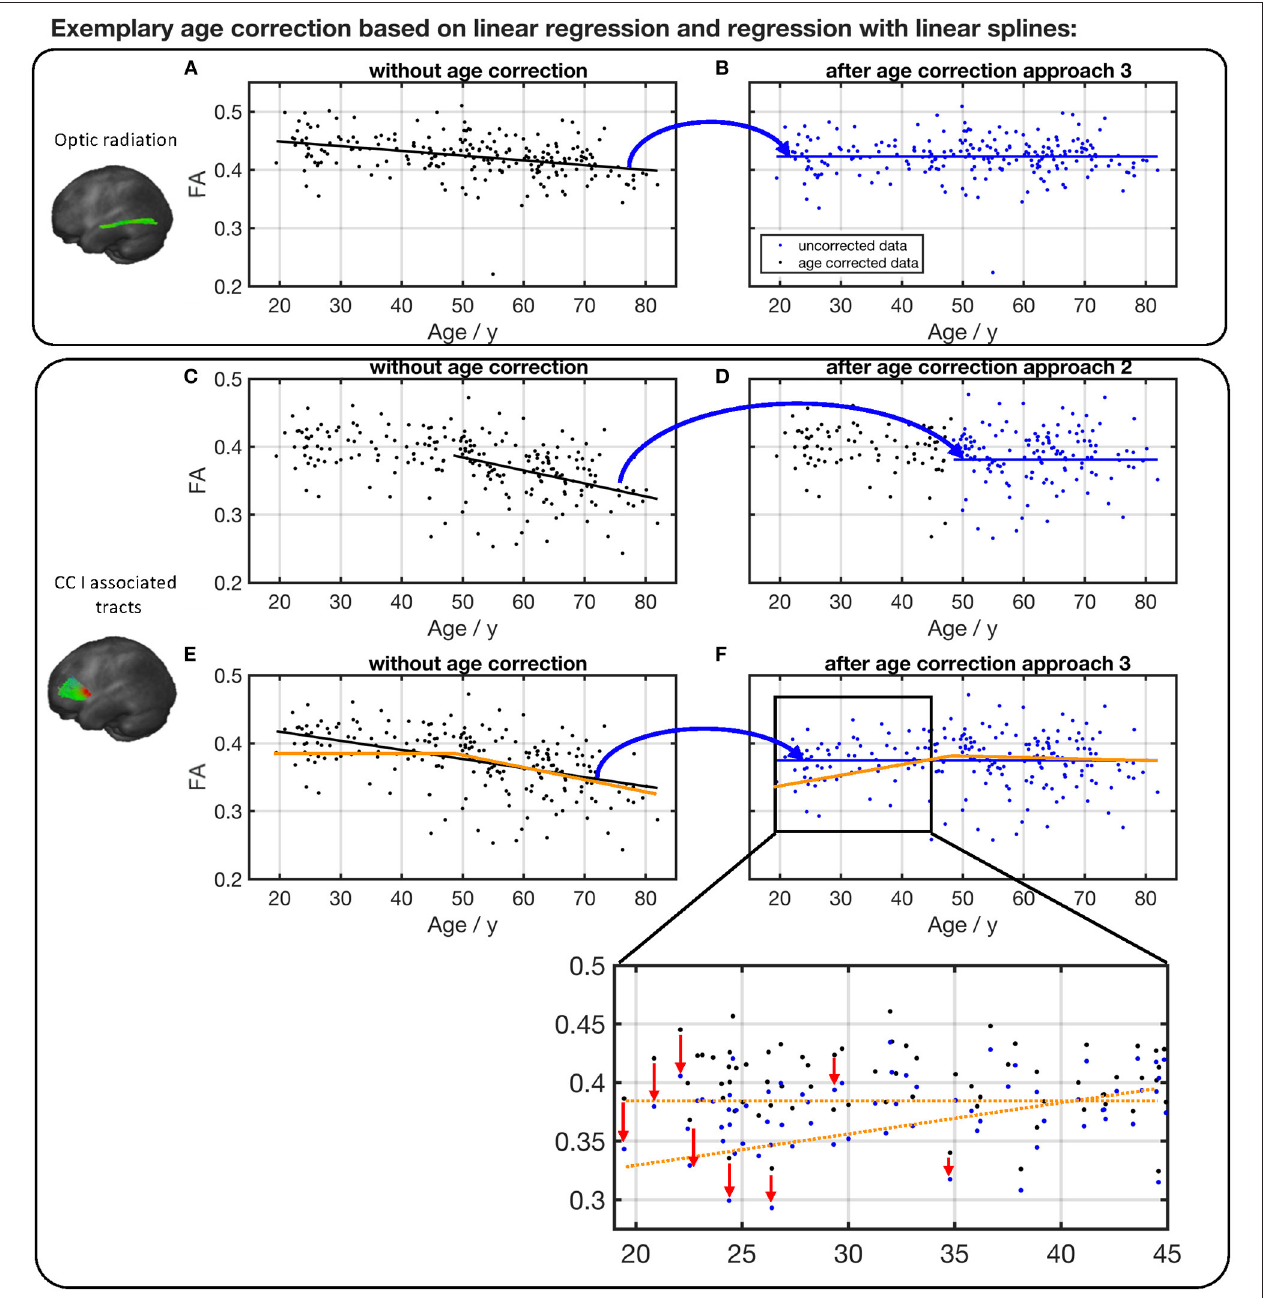
FIGURE 9 | Comparison of different age correction approaches for the exemplary tract optic radiation (A,B) and CC area I-associated tracts (C–F) . (A) Measured FA values in optic radiation and linear regression line before age correction. (B) FA after age correction approach 3 (see Figure 8 ), based on linear regression over all participants’ age span. Due to age correction, the regression of the corrected data shows a constant FA. (C) Measured FA values in CC I-associated tracts and linear regression line of ages higher than the estimated knot position. (D) FA after age correction approach 2 (see Figure 8 ). (E) Measured FA values and linear regression (black) over all participants’ age span. The orange line serves as a guide to the eye and demonstrates the two-phase age-associated behavior. (F) FA after age correction approach 3. The red arrows in the zoom demonstrate on some examples the shift in FA values at the lower end of the age range due to an age correction based on a linear regression over the complete age range.